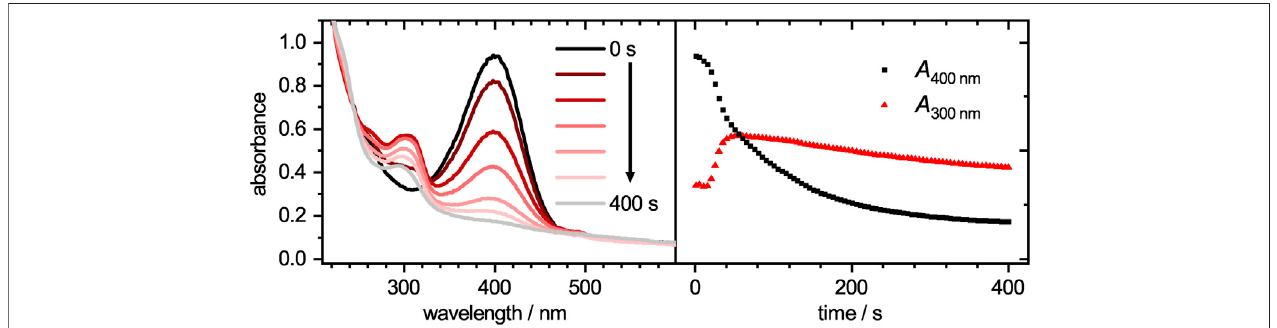
FIGURE 5 | Absorbances plotted against the wavelength (left) for the catalytic degradation of 4-nitrophenolate to 4-aminophenol with palladium loaded microgels as catalyst at different times. The time-dependent absorbance intensities at wavelengths of 300 and 400 nm are plotted on the right. While 4-nitrophenolate, which absorbs mainly at 400 nm, decays, the product 4-aminophenol at 300 nm arises. Since the microgel has a wavelength-dependent scattering, the baseline intensity increases with decreasing